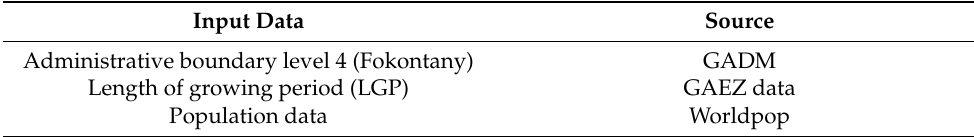
Table 1. Input data for assessing the risk of changing climate in the Analamanga region of